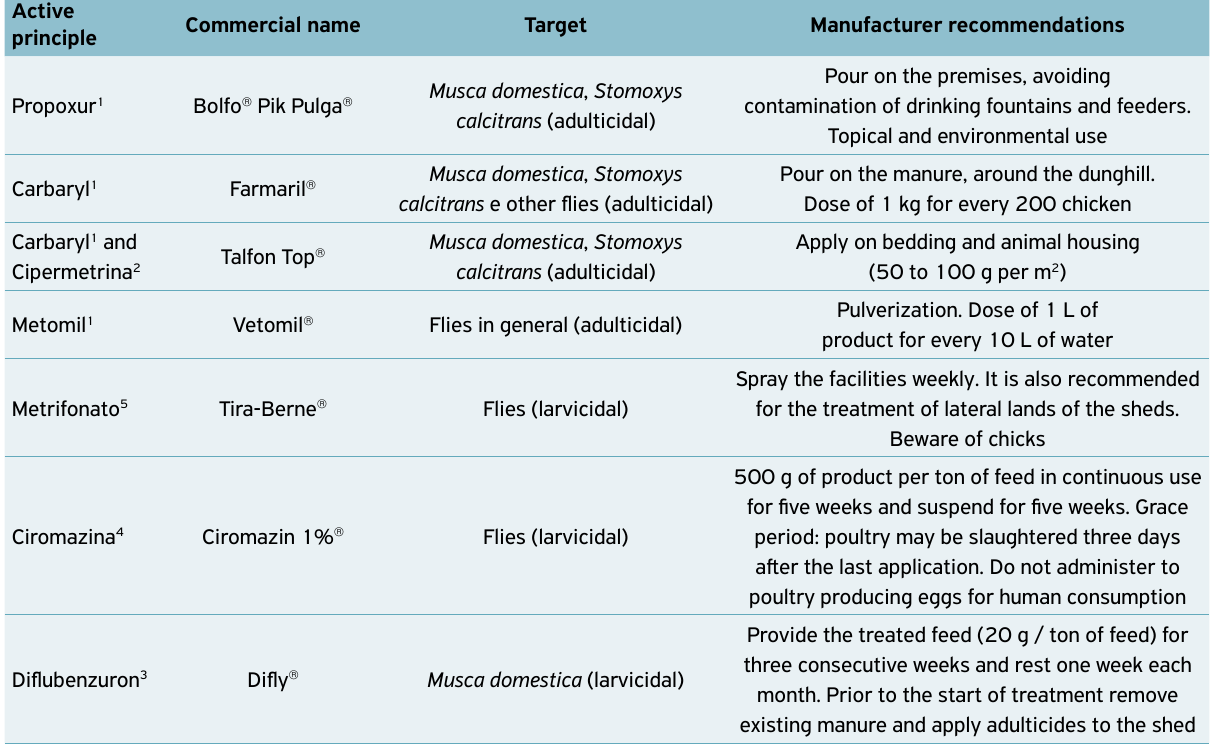
Table 1. Pesticides available in the Brazilian market for control of flies in poultry